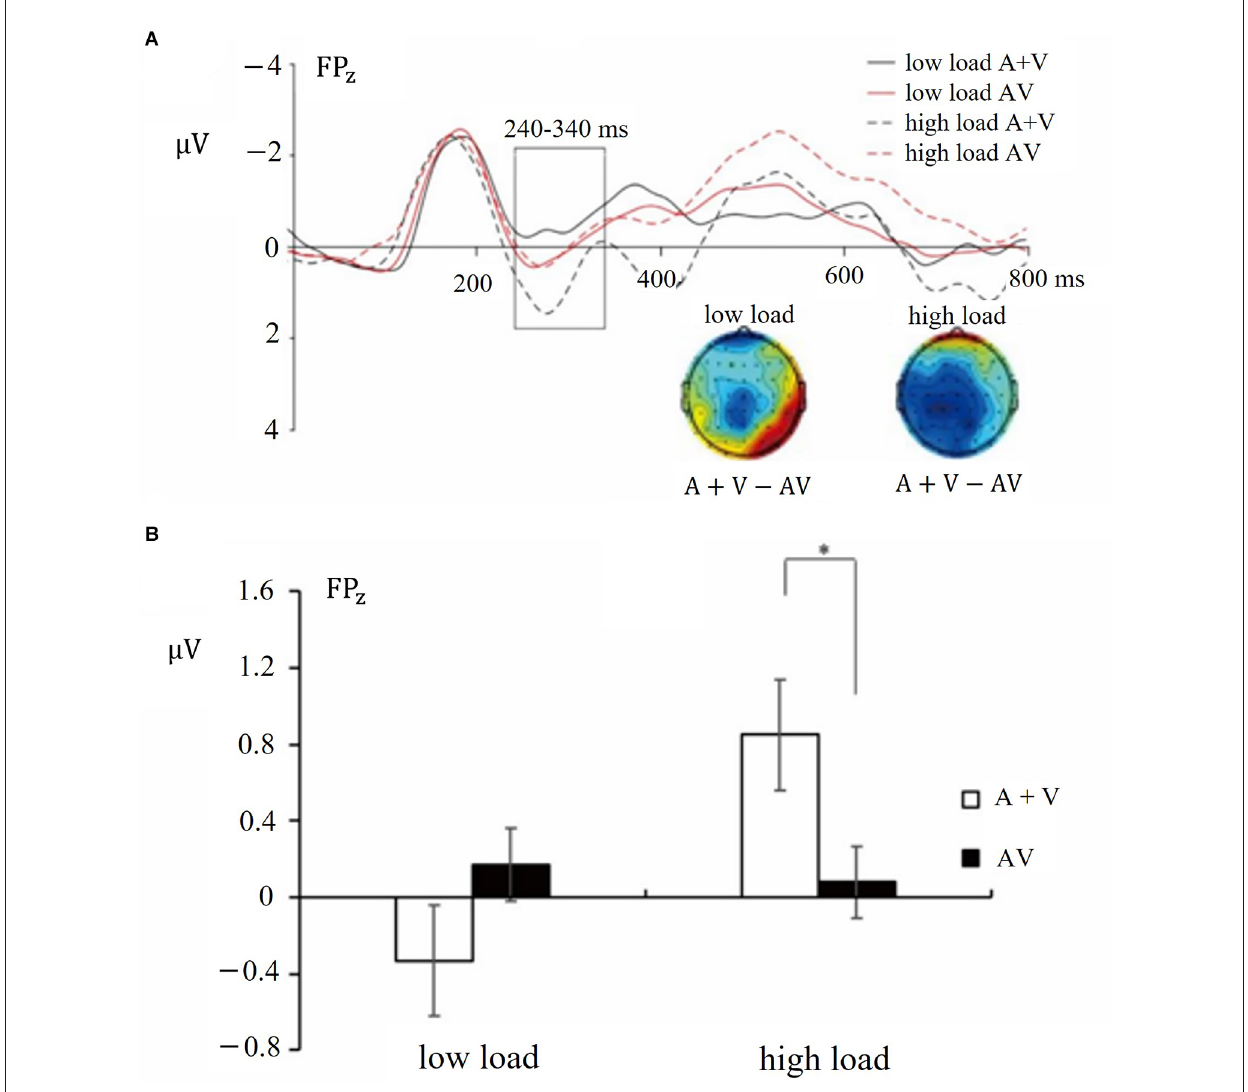
FIGURE4 (A) Grand-average distractor-synchronized ERP waveforms at each experimental condition. Time window of 240–340 ms is highlighted in the box (electrode